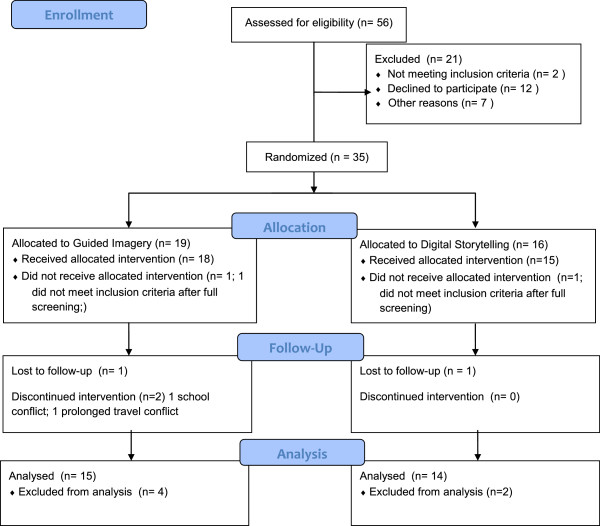
Consort flow diagram.